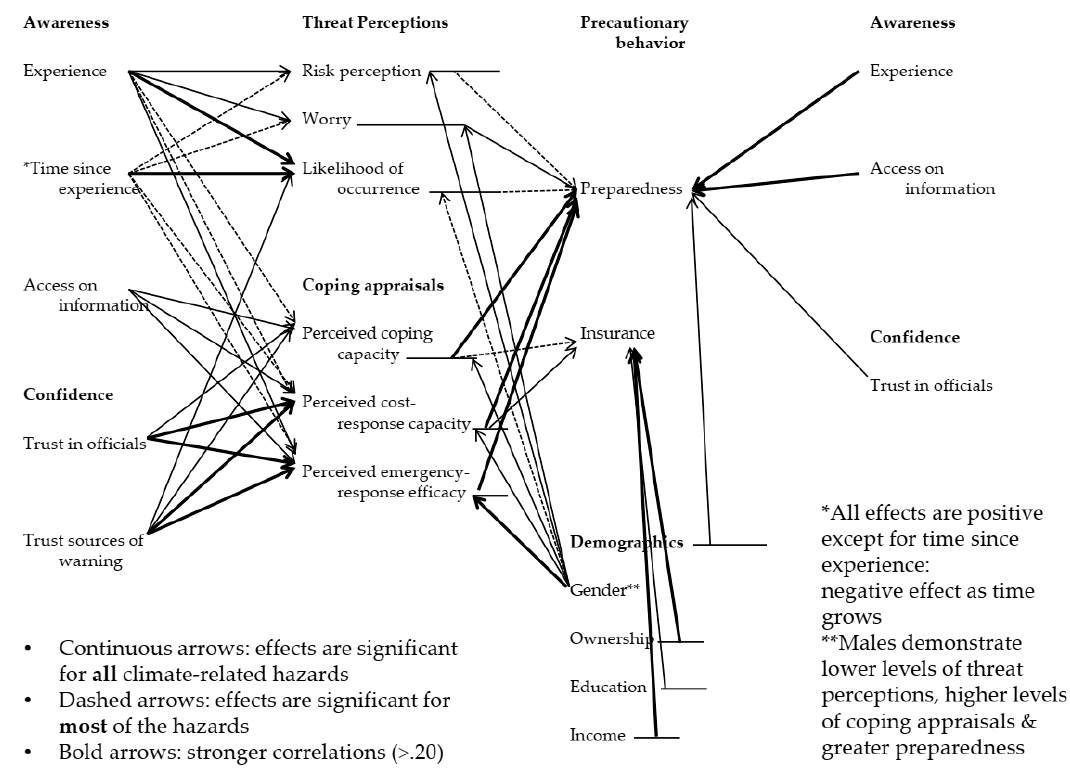
Figure 11. Cognitive map of the statistically significant correlations found between the survey variables related to the hydrogeological and other climate-related hazards.